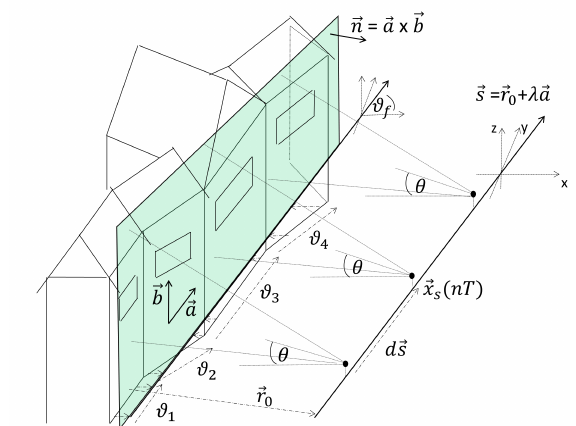
Figure 1. Representation of facade focusing geometry by carborne upward looking stripmap SAR. The focusing plane is indicated in